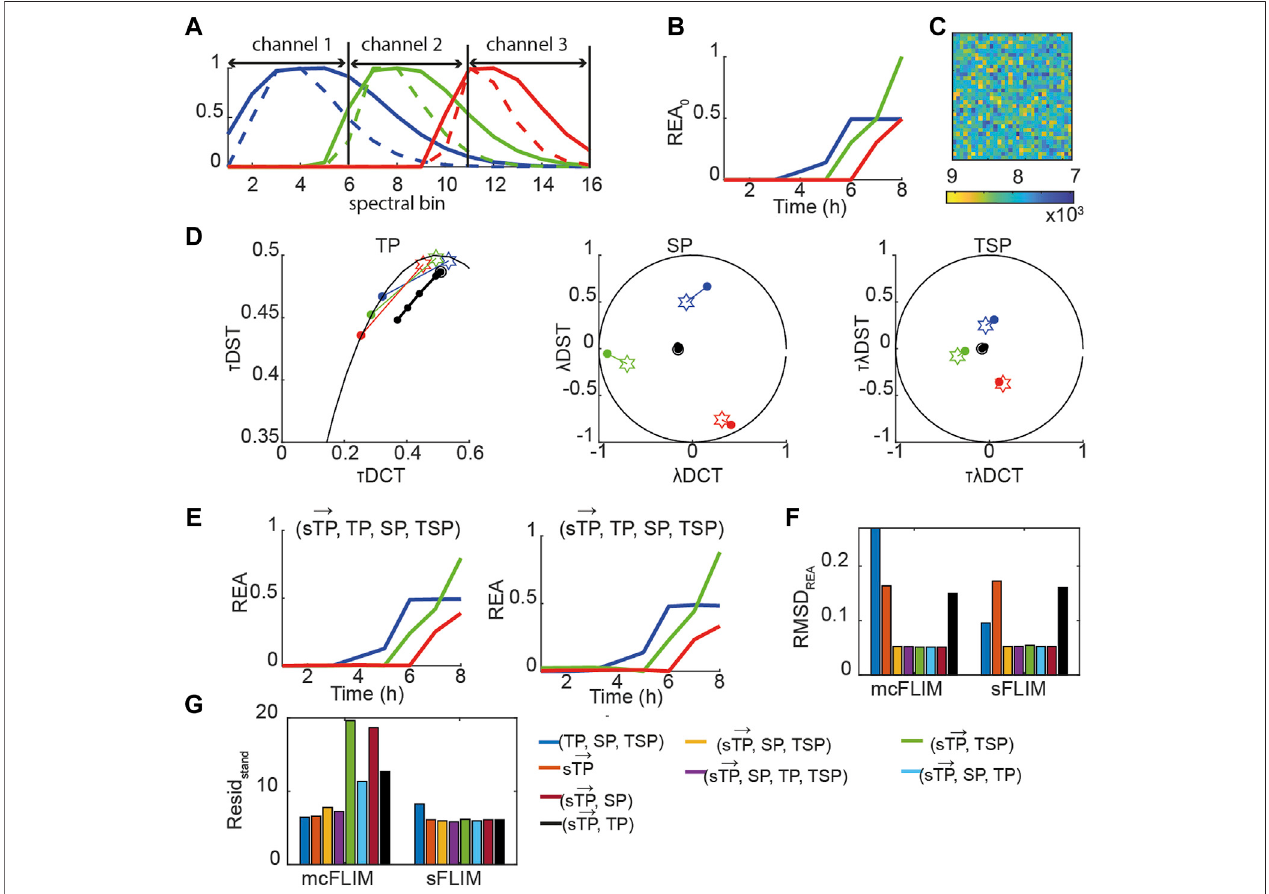
FIGURE 6 | Multidimensional phasor-based demixing of high multiplexed synthetic data. (A) Spectra of the simulated blue (blue solid line), green (green solid line), and red (red solid line) positive controls (uncleavable sensors) and of the corresponding negative controls (only donors, dashed lines). Each curve was normalized to the maximum.Dataweresimulatedas16spectralbins,andchannel1 – 3showwhichbinsweresummedtoobtainthree-channelmcFLIM. (B) AsimulatedREA 0 curves. (C) A simulated noisy image. (D) Time-lapse simulated data combining three sensors. Data are represented in the TP, SP, TSP phasor subspaces. The black circles andlinesrepresentthebiochemicaltrajectoryofasimulateddata.Starsrepresentthereference fi ngerprintsoftheuncleavablesensors(labeled B , G ,and R ),andcolored (cid:1)(cid:1)(cid:1) → circles show the donor-only references (labeled b , g , and r ). (E) The results of demixing using ( sTP , TP , SP , and TSP ) for sFLIM (left) and mcFLIM (right) (see also Supplementary Figure S6 ). (F) REA RMSD. (G) . The phasor standarised residuals for sFLIM (left) and mcFLIM (right) (see also Supplementary Figure S7